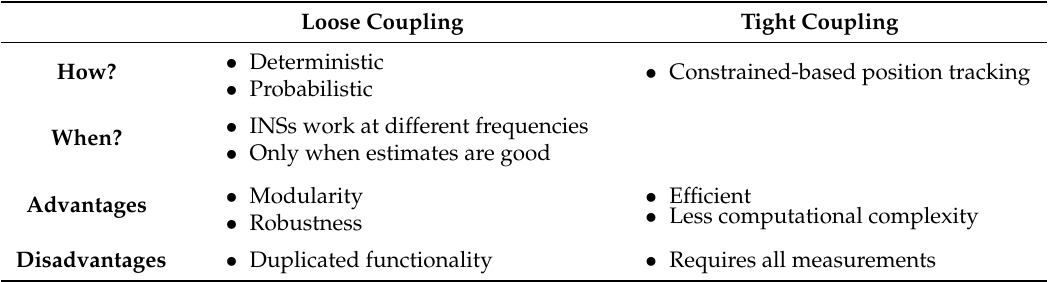
Table 1. Approaches to multiple inertial measurement unit (multi-IMU)